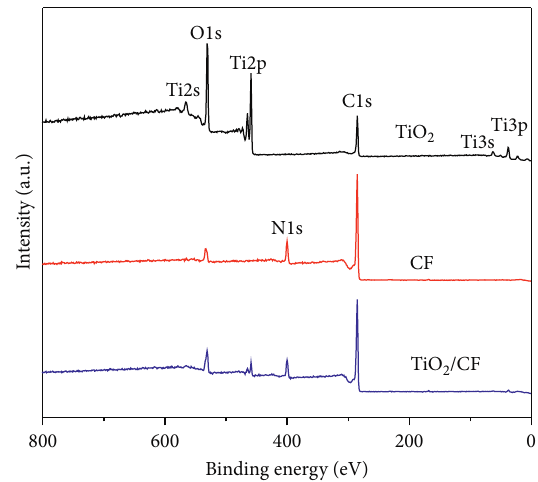
Figure 5: XPS spectra: survey